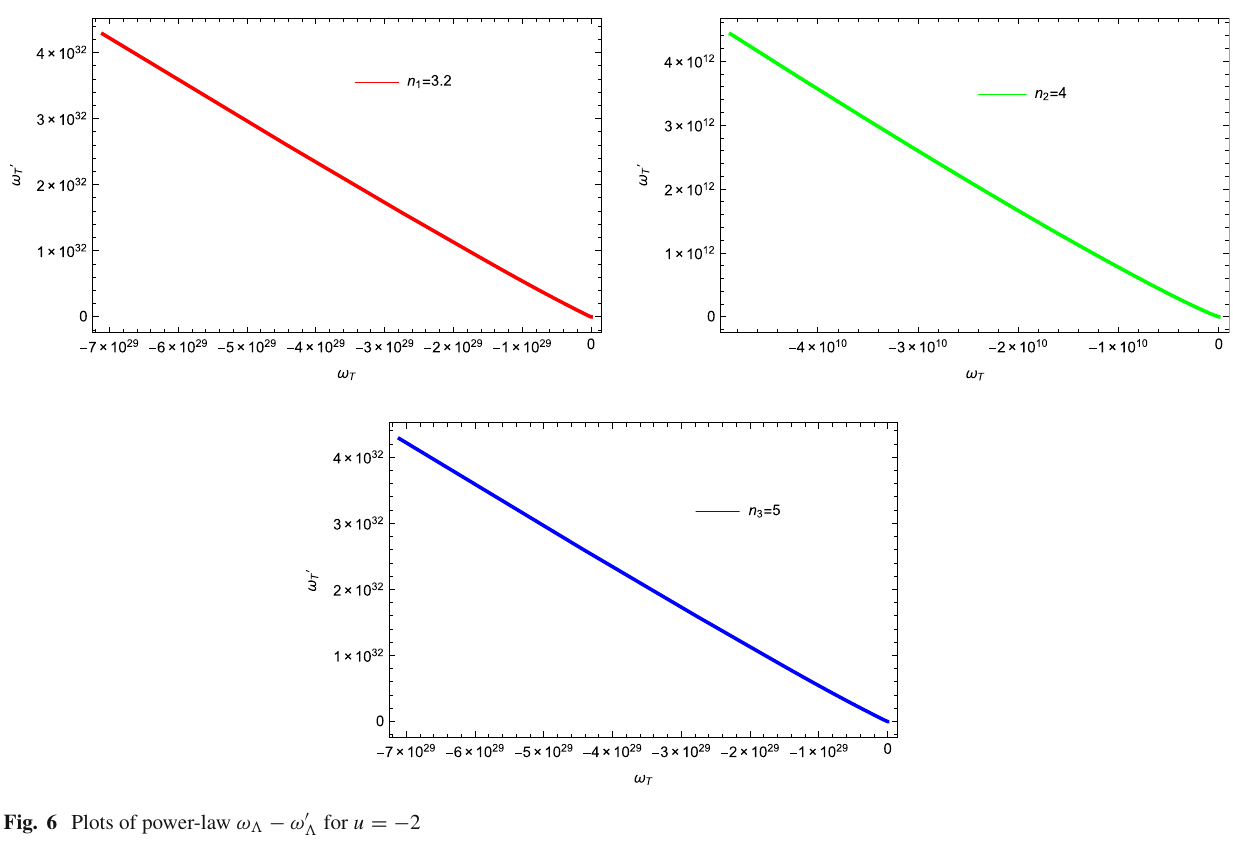
Fig. 6 Plots of power-law ω (cid:3) − ω (cid:2) (cid:3) for u = −